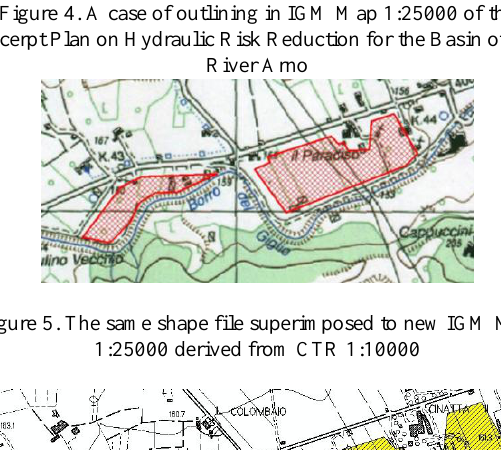
Figure 4. A case of outlining in IGM Map 1:25000 of the